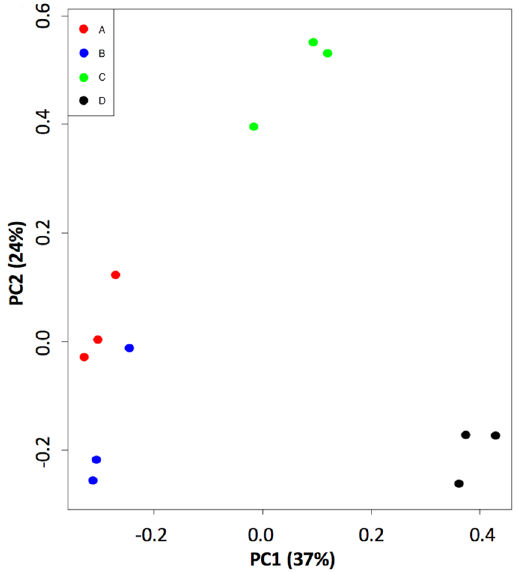
Figure 3. PCA plot of the data. Depicted are triplicate samples from Condition ( A ) (red) ( B ) (blue), ( C ) (green), and ( D ) (black). See Table 1 for description of the